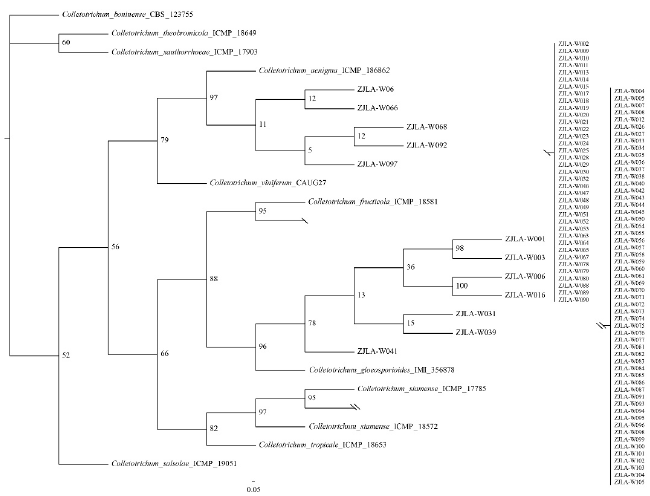
Figure 3. Bayesian inference phylogenetic tree of the Colletotrichum gloeosporioides species complex of isolates obtained from strawberry nurseries located in Zhejiang province. The tree was con- structed with a Bayesian analysis of concatenated actin ( ACT ), calmodulin ( CAL ), chitin synthase ( CHS- 1 ), glyceraldehyde-3-phosphate dehydrogenase ( GAPDH ), and internal transcribed spacer (ITS). The Markov chain was run for 1,000,000 generations, each locus having a separate model of DNA eval- uation. C. boninense (CBS: 123755) was used as an outgroup. The scale bar shows 0.05 expected changes per site.